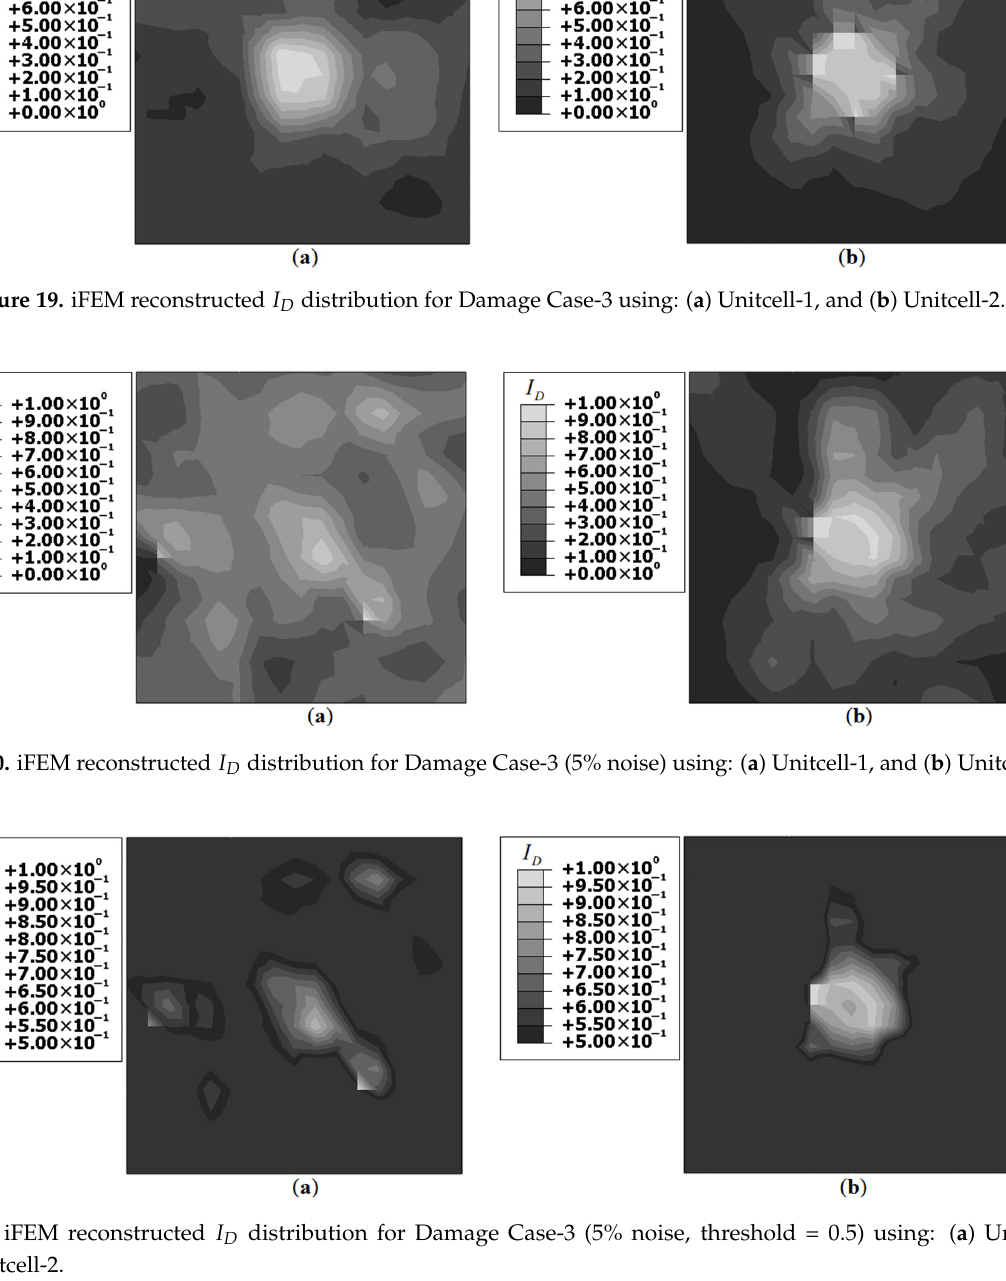
Figure 21. iFEM reconstructed 𝐼 (cid:3005) distribution for Damage Case-3 (5% noise, threshold = 0.5) using: ( a ) Unitcell-1, and ( b ) Unitcell-2.